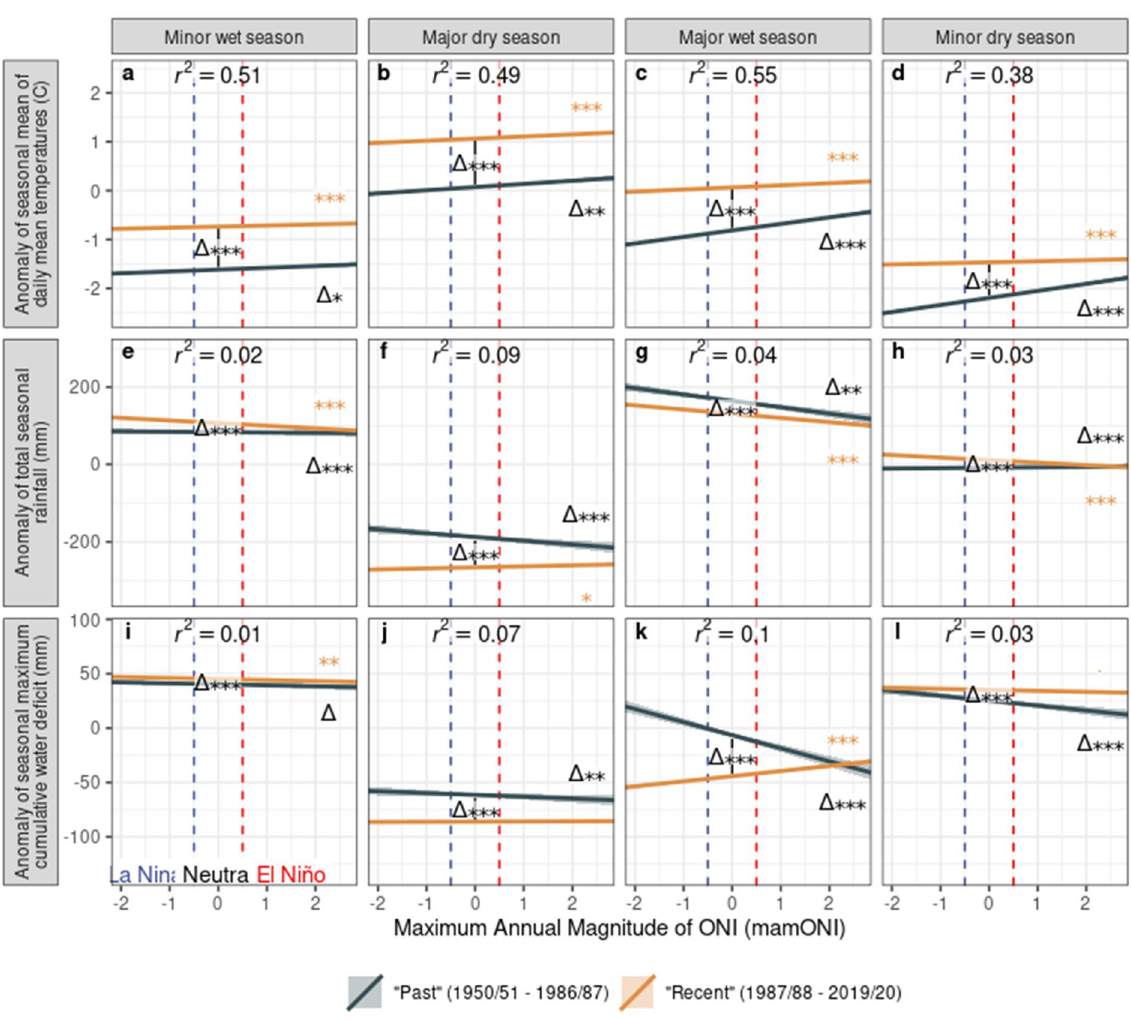
Figure 4. The response of climate to mamONI in different seasons during the purchase year, grouped into two sets of years corresponding to the best fitting break-point in the production data. Seasons are shown in chronological order during the purchase year. Vertical dashed lines delineate La Nina (mamONI ≤ − 0.5), Neutral (− 0.5 < mamONI < 0.5) and El Nino (mamONI ≥ 0.5) conditions. Lines show the best linear fits and standard errors derived from 12 individual regressions of seasonal climate against mamONI, with an interaction term fitting the year category. Significance stars denote p-values derived from these models (***p < 0.001, **p < 0.01, *p < 0.05, .: p < 0.1): (1) difference in means between year groups (delta in centre of plot), (2) difference of the 1987/1988–2018/2019 slope from 0 (orange stars at right of plot), (3) difference between slopes (delta at right of plot). The adjusted R squared value is displayed for each